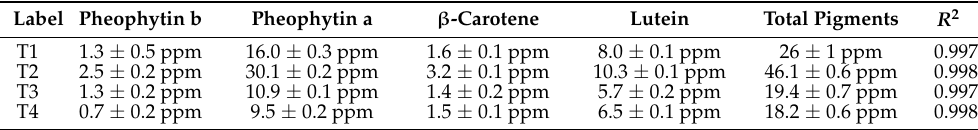
Table 4. Values of concentration (expressed in ppm) of four main pigments in ‘on-the-shelf’ EVOOs (i.e., pheophytin a, pheophytin b, β -carotene and lutein) as obtained from the deconvolution analysis of UV-vis absorption spectra the EVOO samples, after about 4 months from their production. Total amount of pigments is also reported. For each EVOO sample the concentration values obtained from the best fitting analysis are shown with the respective value of R 2 .